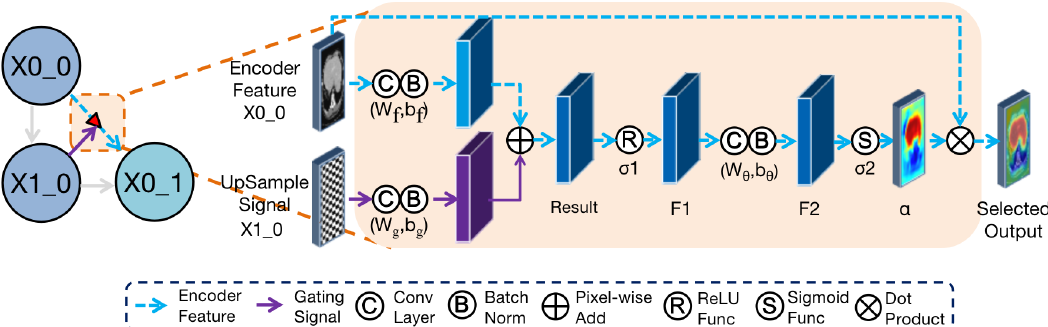
Figure 3. Diagram of Attention gate between convolutional block X 3_0 and X 3_1 . The feature of X 4_0 is used as a gate signal to focus regions in the encoder feature of X 3_0 . These two features are added after the convolution and BatchNorm layers.After activation by ReLU, the result is sent to the convolution and BatchNorm layers to extract features. Finally, the attention coefficient α is obtained through the sigmoid function and then it dot-products, pixel by pixel, by using the upsampling feature to get the feature after attention selection, which is X 3_1